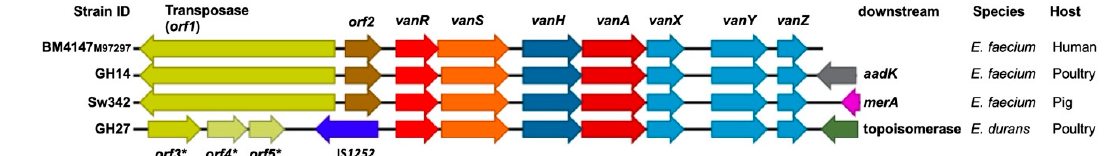
Figure 1. Average nucleotide identity (ANI) based cluster dendrogram showing three types of Tn 1546 -like elements carrying vanA operons identified in 23 vanA - type vancomycin-resistant enterococci from healthy food-producing animals. Type I corresponds to the prototype Tn 1546 (GenBank M97297) from human E. faecium B4147 [35]. Type II additionally carries an IS 1252 in the orf2 - vanR intergenic region. Changed information is highlighted in grey.